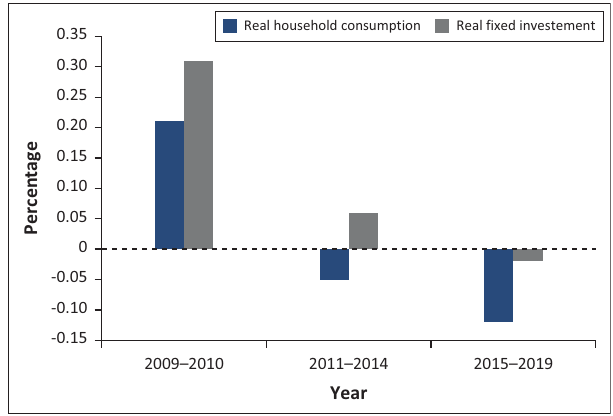
FIGURE 9: Average response of key variables (1st year of impact % deviation from